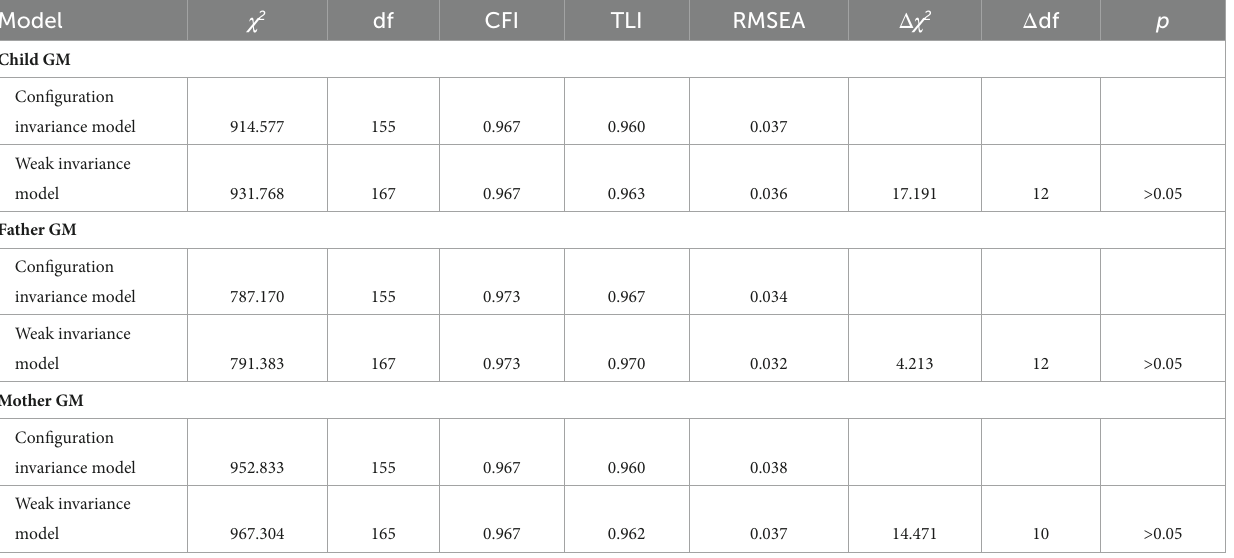
TABLE 2 Longitudinal confirmatory factor analysis on growth